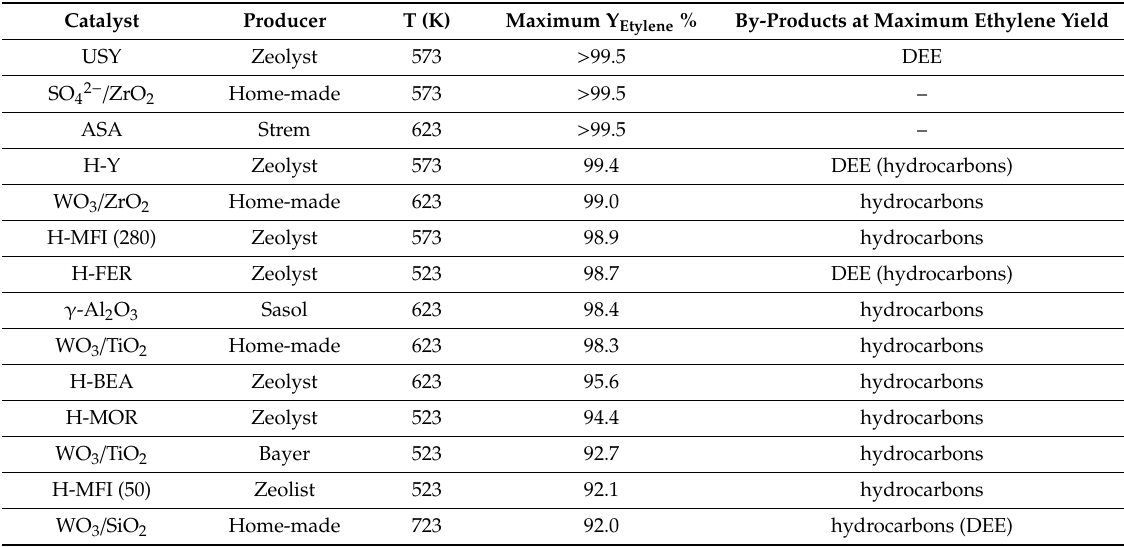
Table 4. Maximum ethylene yields obtained on di ff erent acid catalysts, and